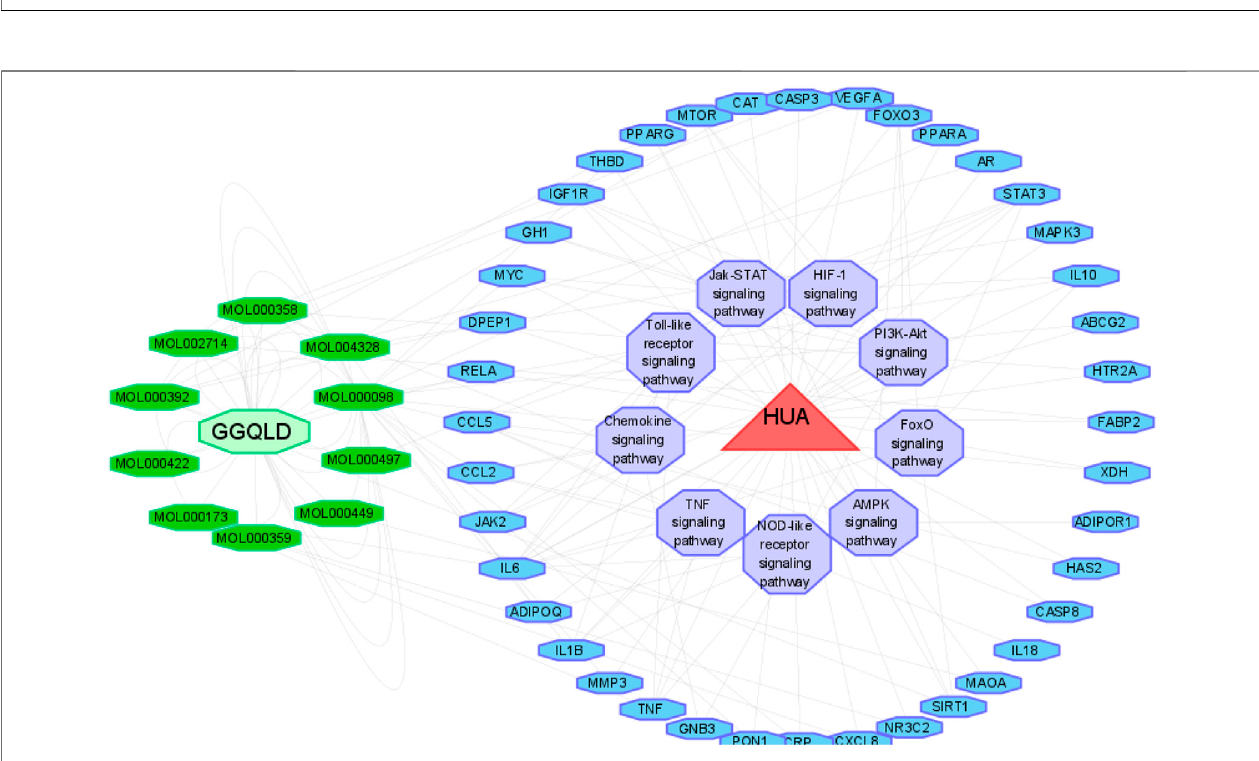
FIGURE 2 | Potential therapeutic mechanisms of GGQLD in hyperuricemia. (A) Bubble chart of the top 35 signaling pathways screened by using the KEGG enrichment analysis. (B) Venn diagram showing the overlap genes between fi ve types of pathways. (C) Protein – protein interaction and gene coexpression network.